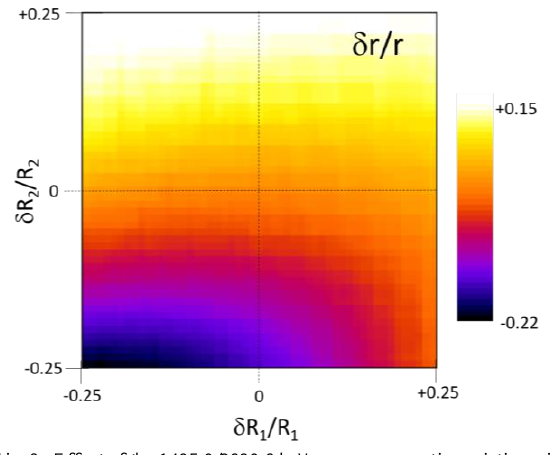
Fig. 8. Effect of the 1435.9/2639.6 keV gamma-ray ratio variations, in positions 1 and 2 (R 1 and R 2 , respectively), on the sample radius r.